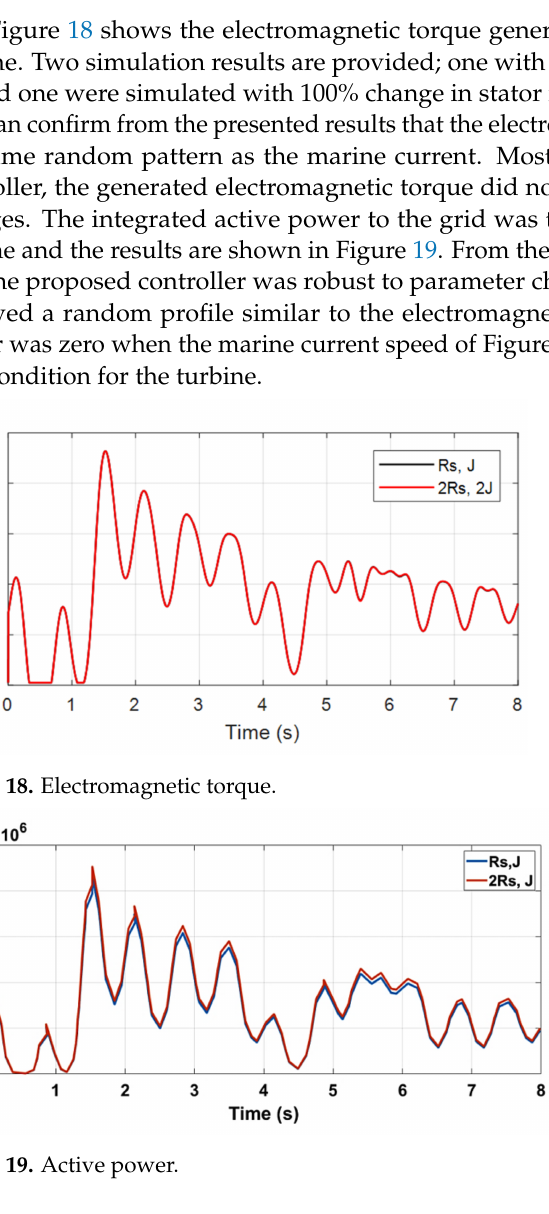
Figure 17. Random marine current speed.